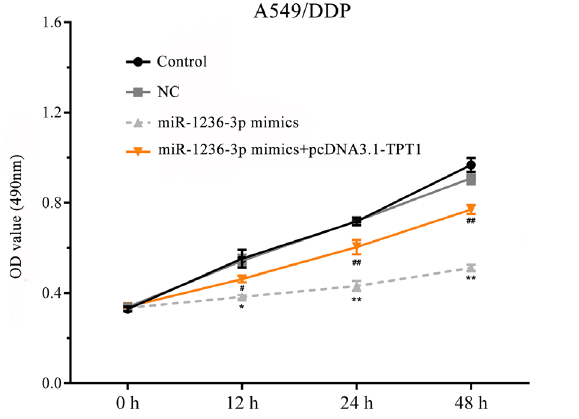
Figure 6: Effect of miR-1236-3p on the proliferation of A549/DDP cells. Up-regulation of miR-1236-3p significantly decreased the proliferation rate of A549/DDP cells, which were reversed by TPT1. **P<0.01, miR-1236-3p mimics vs NC group. #P<0.05, ##P<0.01,